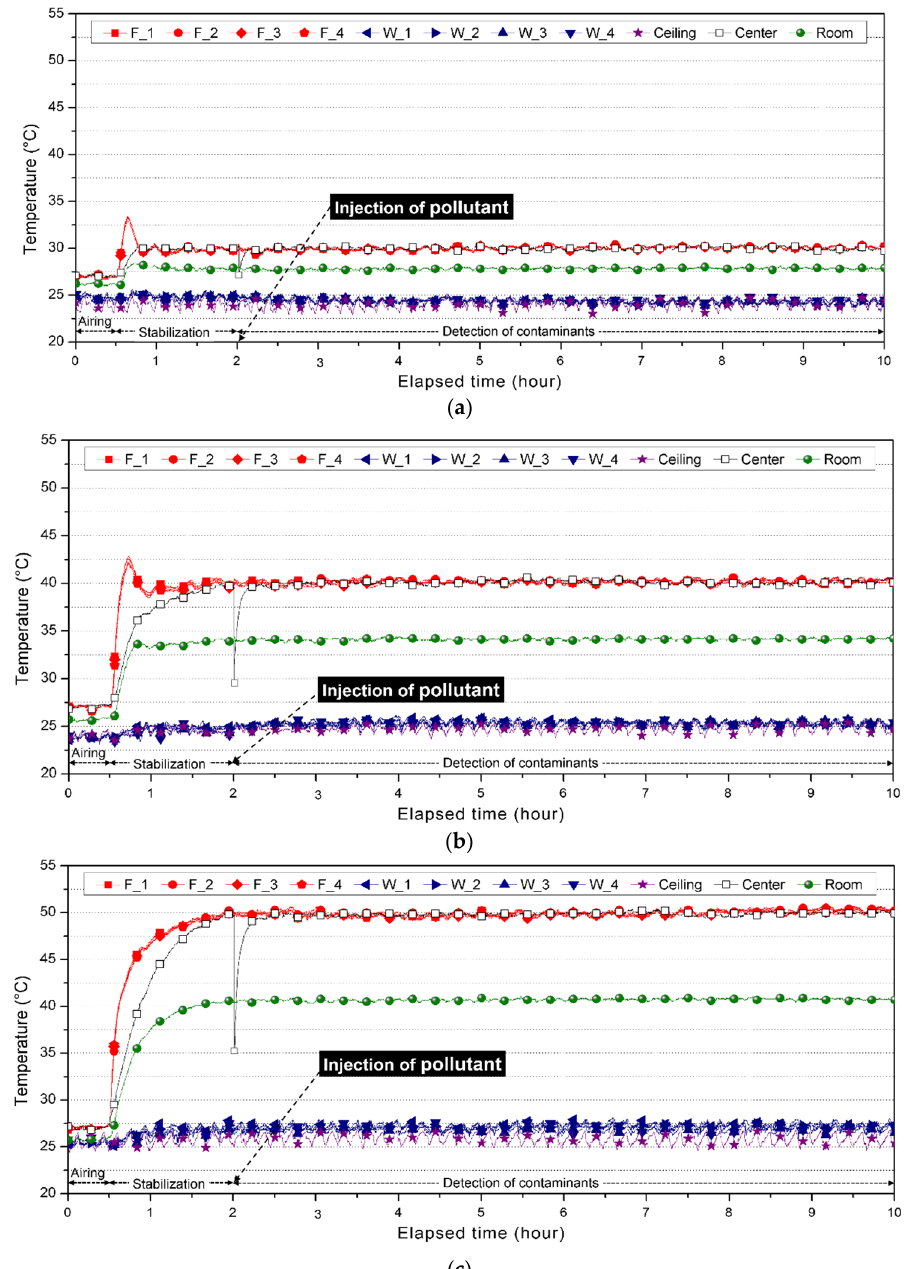
Figure 4. Temperature change over time per case: ( a ) Case 1 (Floor heating set temp. 30 °C); ( b ) Case 2 (Floor heating set temp. 40 °C); ( c ) Case 3 (Floor heating set temp. 50 °C).